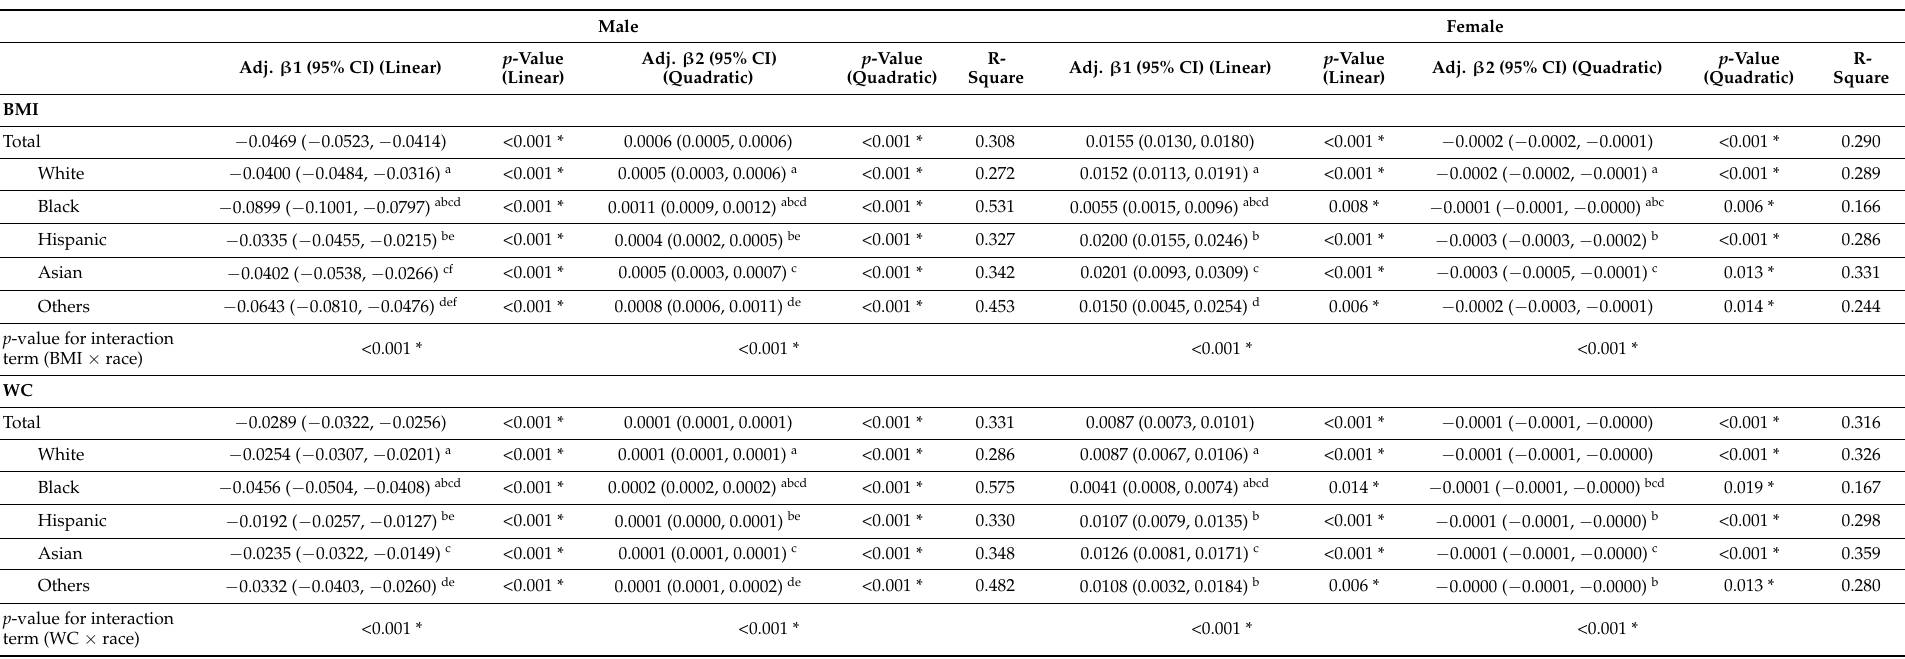
Table 3. The relationships between BMI, WC and